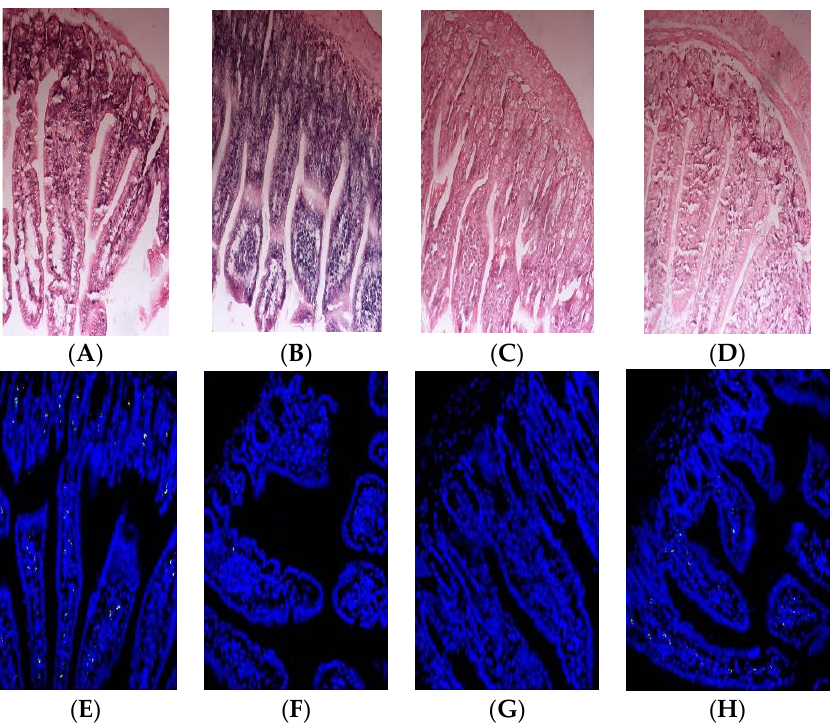
Figure 4. Histopathological observation of small intestines ( A – D ) and apoptosis results of intestinal villi epithelial cells ( E – H ) in Balb/c mice. ( A , E ) corresponds to β -lactoglobulin positive control group (PC); ( B , F ) corresponds to normal saline negative control group (NC); ( C , G ) corresponds to the TH group with early gastric administration of β -lactoglobulin trypsin hydrolysate (TH) added to whey protein concentrate; ( D , H ) corresponds to the mice group with early gastric administration of whey protein concentrate